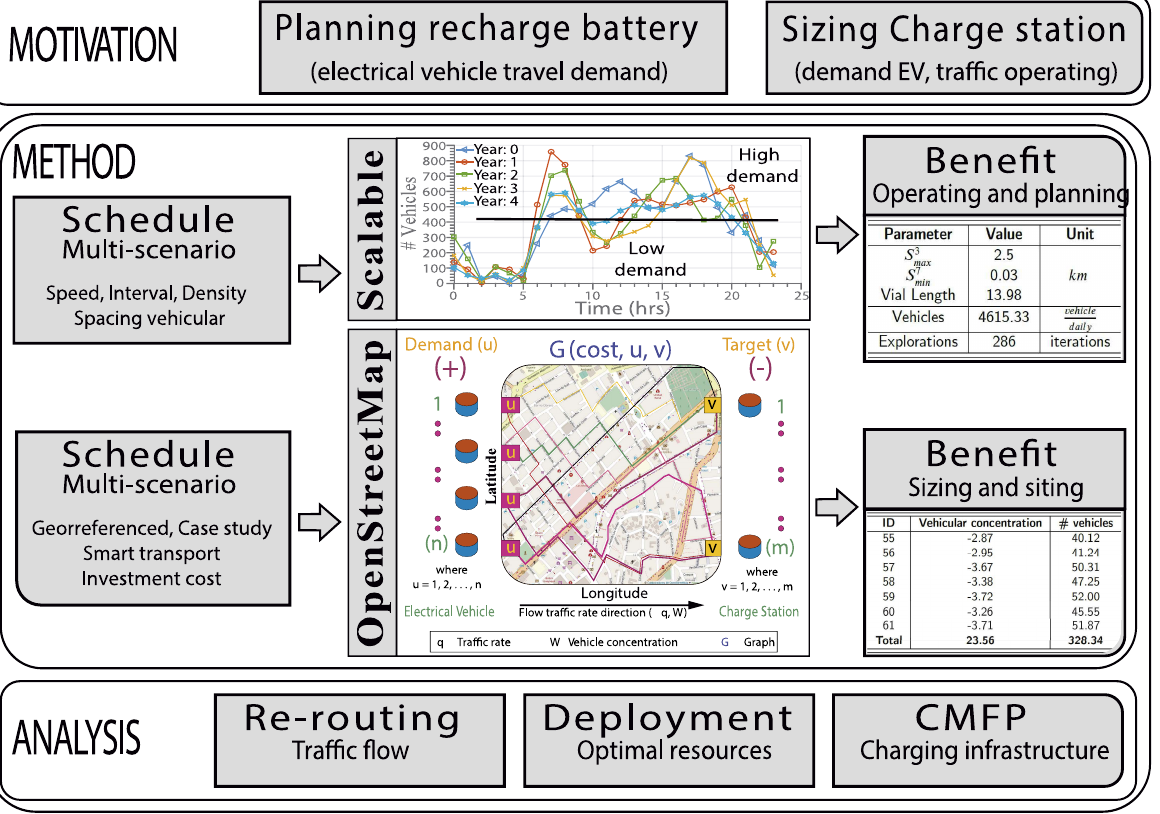
Figure 2. Architecture proposed